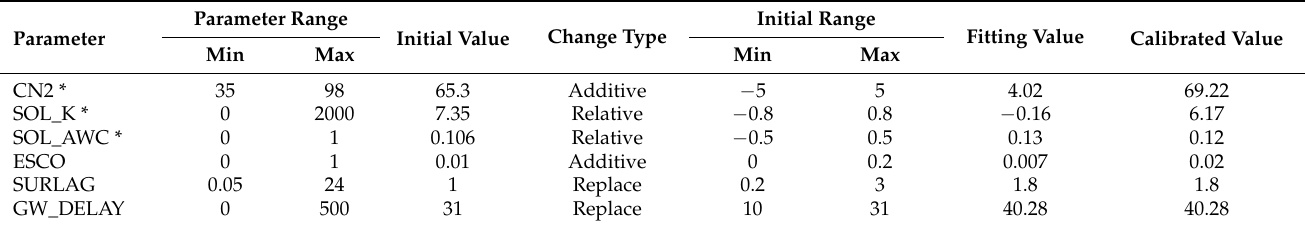
Table 3. Sensitive parameters used for SWAT calibration for AZB.